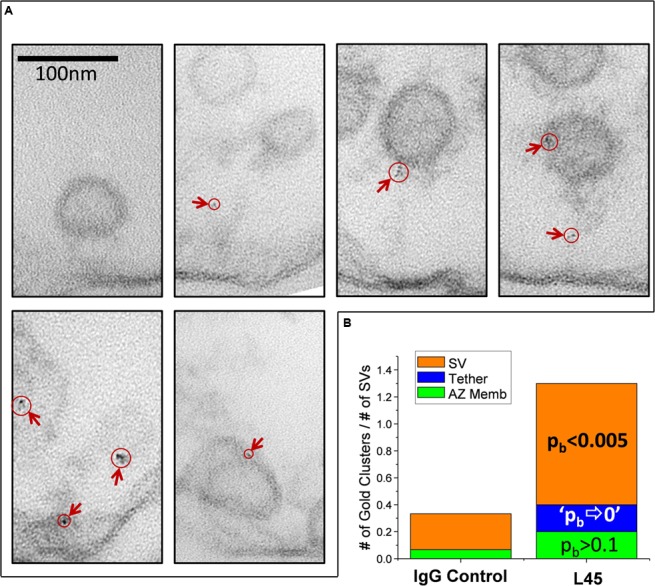
Imaging individual L45 immunogold tethered SVs. (A) Tethered SVs were identified for analysis at a magnification well below that required to detect nanogold. SVs were then photographed at 500K× magnification and nanogold clusters were identified off-line. Each panel shows tethered SVs with nanogold clusters identified by circles and arrows. (B) Analysis of nanogold cluster location on individual tethered SVs. Each tethered-SV nanogold cluster was attributed one of three regions as described in the text: the SV itself, the tether or the AZ membrane region. The number of gold clusters were normalized to the total number of individual tethered SVs analyzed for the IgG controls or L45 (n = 15 and 10, respectively). The significance of the L45 counts was compared to controls using the binomial test. The absence of any nanogold clusters in the tether region of the control dataset resulted in the approximation of p⇒0.